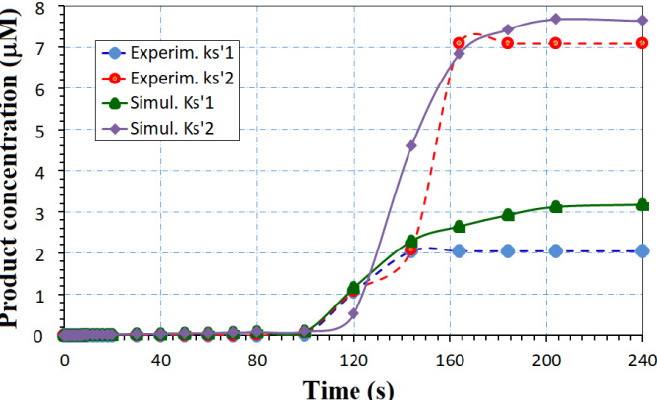
Figure 7. Comparison between the analytical model (17) and few experimental picked points. Experimental points were adapted with permission from Ref. [27].